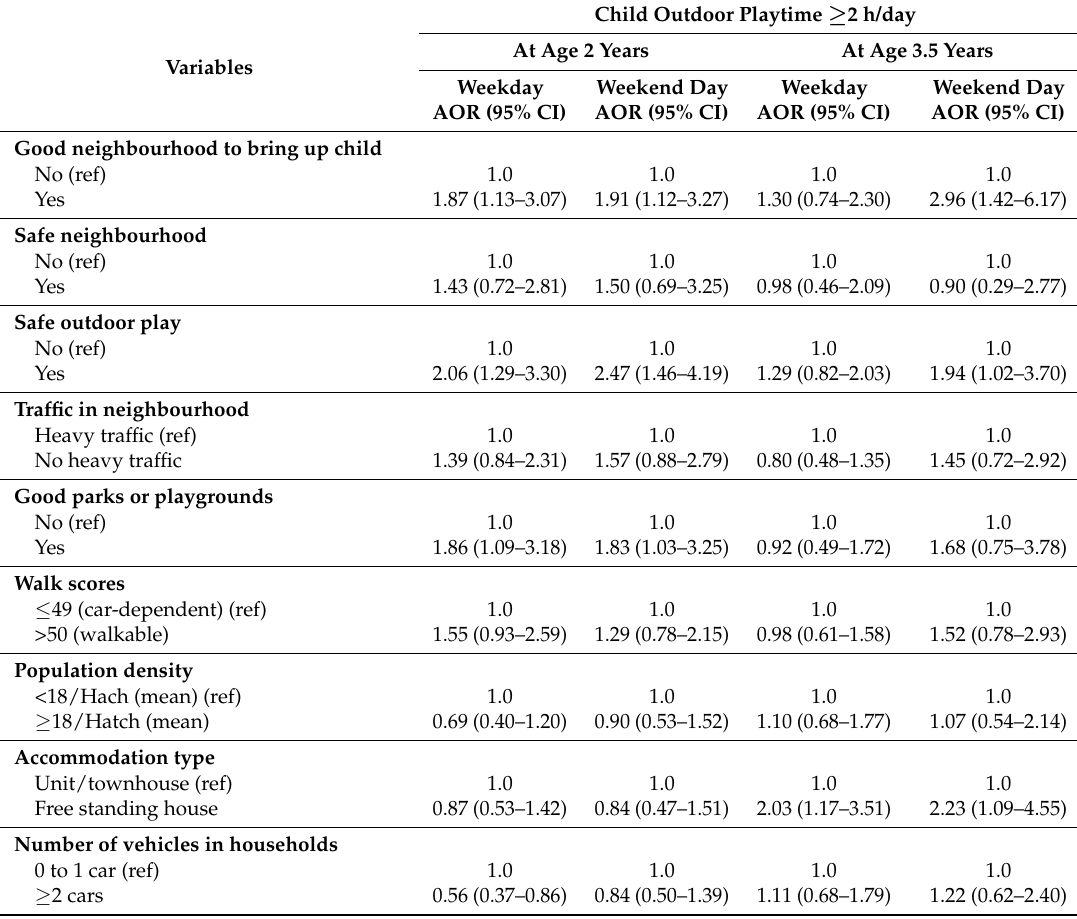
Table 4. Multiple logistic regression analyses of the associations of neighbourhood environment factors with outdoor playtime of 2- to